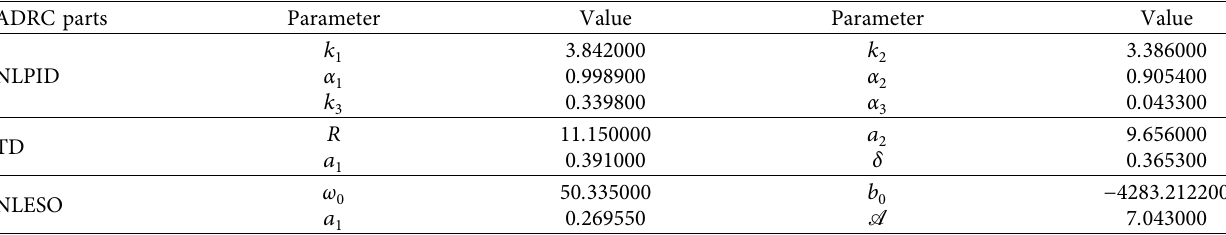
Table 8: NLPID-ADRC parameters.